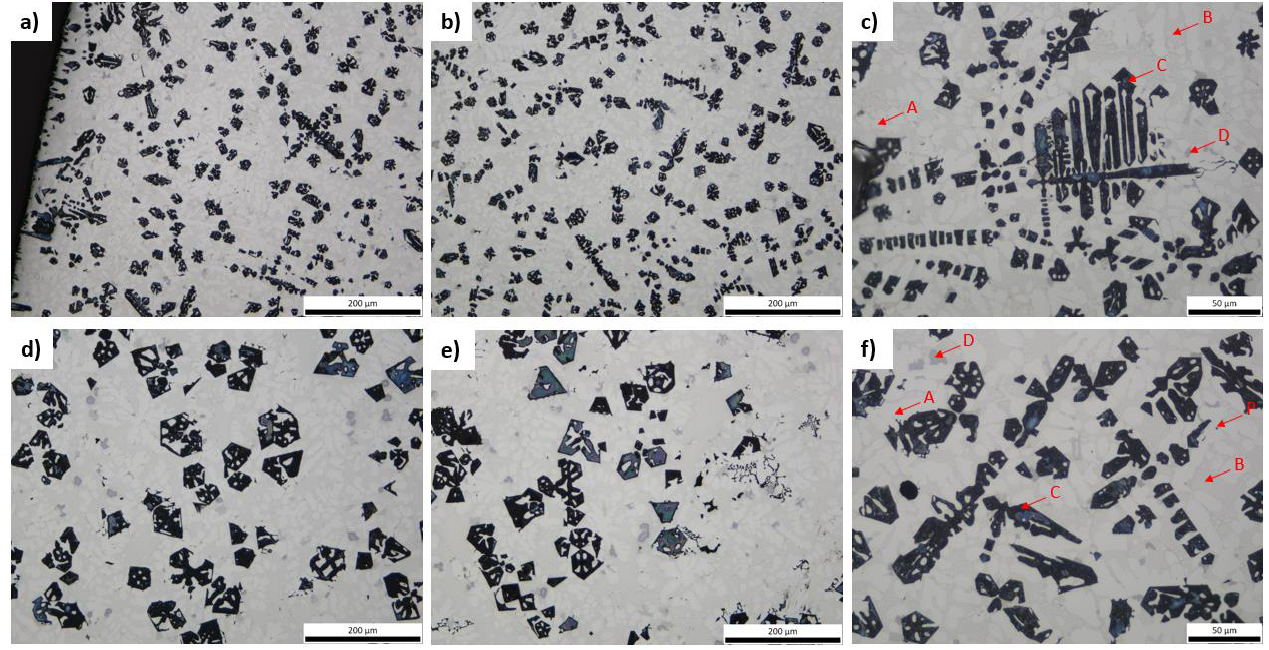
Figure 3. Optical micrographs of 2M ( a – c ) and 1M ( d – f ).